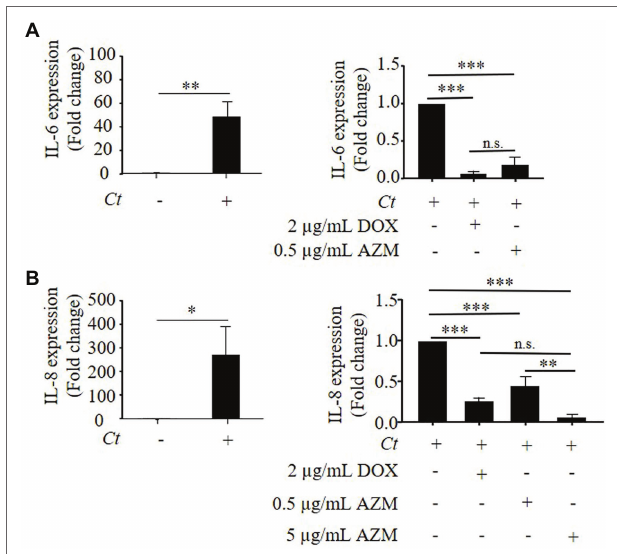
FIGURE 4 | Expression of IL-8 and IL-6 in C. trachomatis infected HeLa cells under treatment with DOX and AZM. (A) Quantitative analysis of IL-6 mRNA expression in C. trachomatis infected HeLa cells under treatment with 2 μ g/ml of DOX or 0.5 μ g/ml of AZM for 24 h. (B) Quantitative analysis of IL-8 mRNA expression in C. trachomatis infected HeLa cells under treatment with 2 μ g/ml of DOX or 0.5 or 5 μ g/ml of AZM for 24 h. Ct , C. trachomatis ; DOX, doxycycline; AZM, azithromycin ( n = 3; Mean ± SEM, Student’s t -Test and Sidak’s multiple comparison: * p ≤ 0.05; ** p ≤ 0.01; *** p ≤ 0.001; and N.S. not